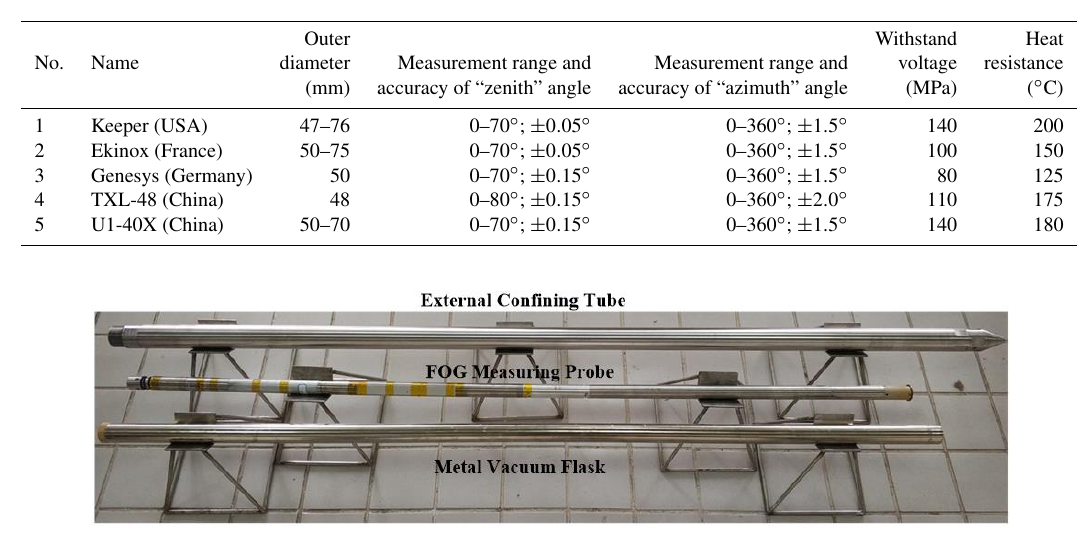
Table 1. Technical parameters of some DTMIs based on FOG.